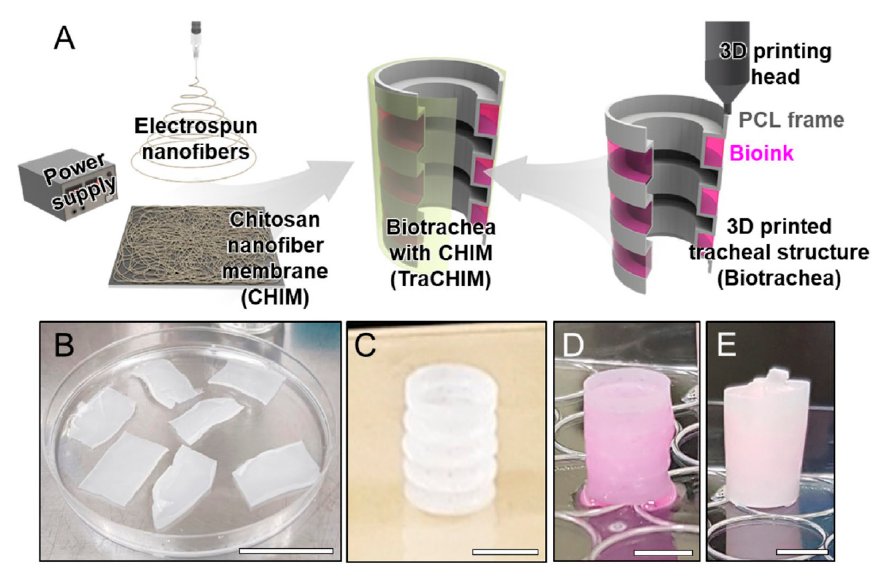
Figure 10. ( A ) 3D-bioprinted tracheal structure (biotrachea) obtained with an electrospun chitosan- based nanofiber membrane (CHIM). Figures ( B – E ) denote the CHIM, 3D-printed PCL frame, bio- trachea, and the biotrachea with CHIM, respectively (reprinted from Kim et al., 2021 [337] . Copy- right © 2022 Springer Nature under the terms of the Creative Commons Attribution 4.0 International License).